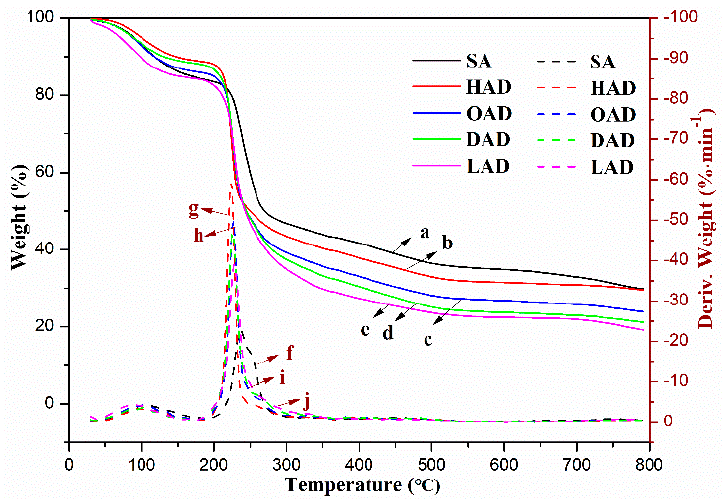
Figure 3. X-ray diffractograms of SA, HAD, OAD, DAD, and LAD.